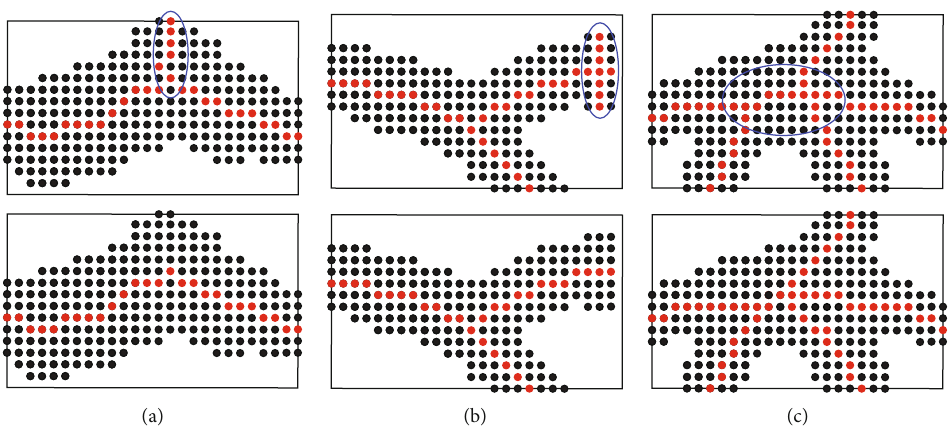
Figure 4: Optimization of pore axis: (a) optimization of short branch central axis; (b) correction of boundary central axis; (c) correction of central axis node.